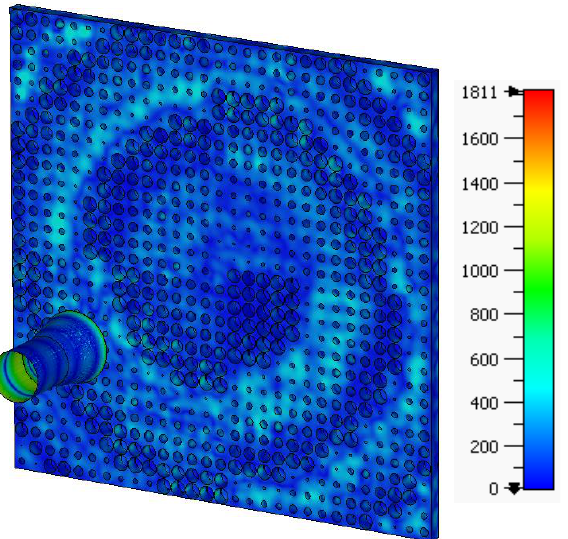
Figure 11: Electric field distribution of the proposed HPM reflectarray